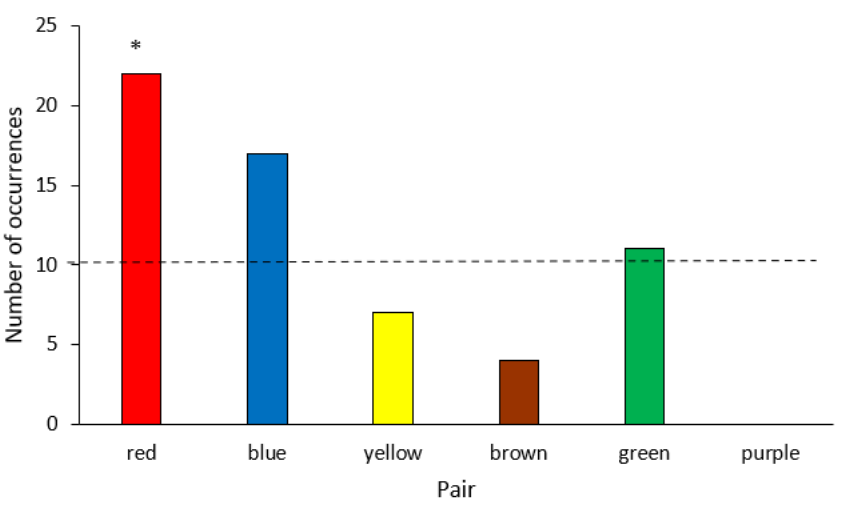
Figure 4. Frequency of allo-preening over 19 observation days based on Animal Behaviour Pro data. Red pair allo-preened significantly more than all other pairs, and Purple pair did not allopreen at all. Dashed line equals the expected frequency of allo-preening if there were no differences amongst pairs; * = p < 0.05.